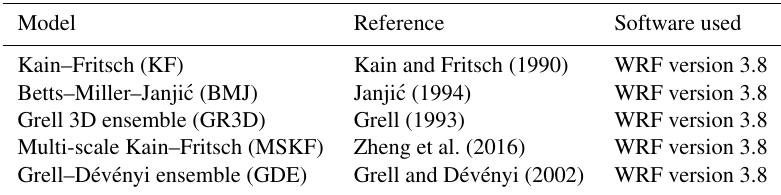
Table 1. Common cumulus parameterization